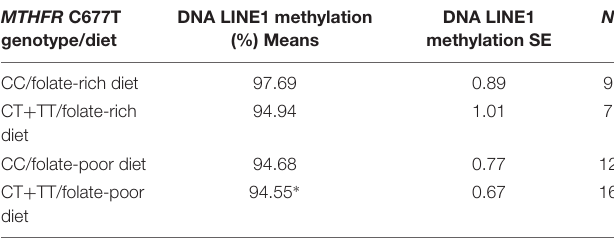
TABLE 3 | LINE-1 methylation in mothers of children with DS with congenital heart defects (CHDs) according to the MTHFR C677T genotype/diet combination. MTHFR C677T genotype/diet